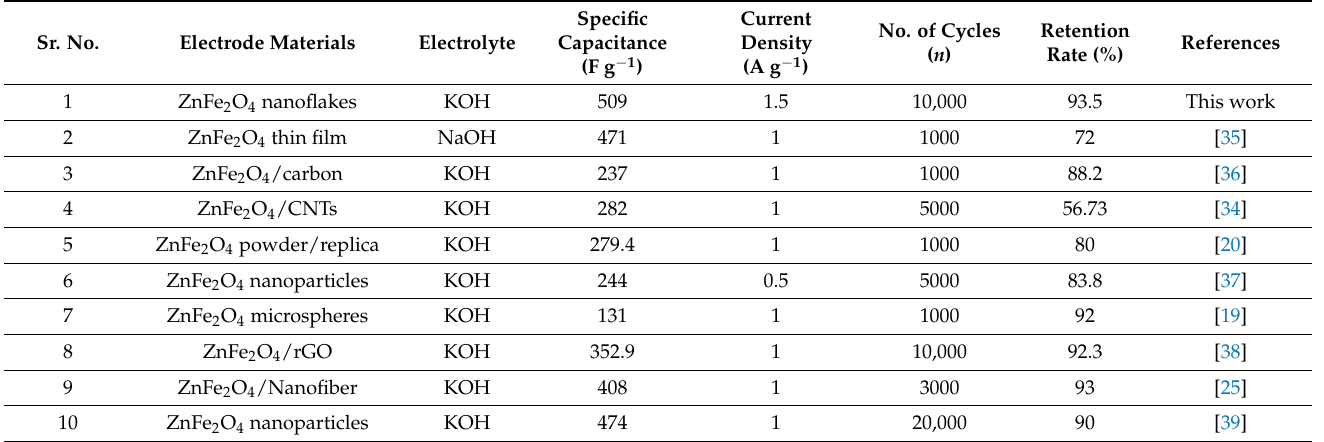
Table 1. Comparative study of specific capacitance values already reported for ZnFe 2 O 4 -based electrodes with those found in the present